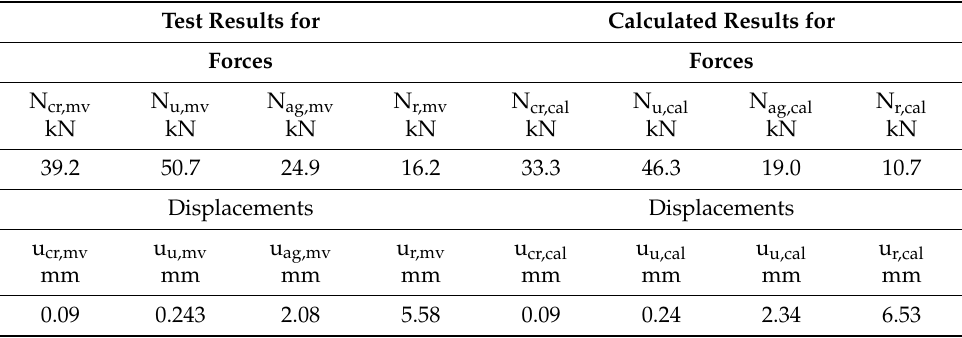
Table 7. Compared test results and our own calculations for the standard